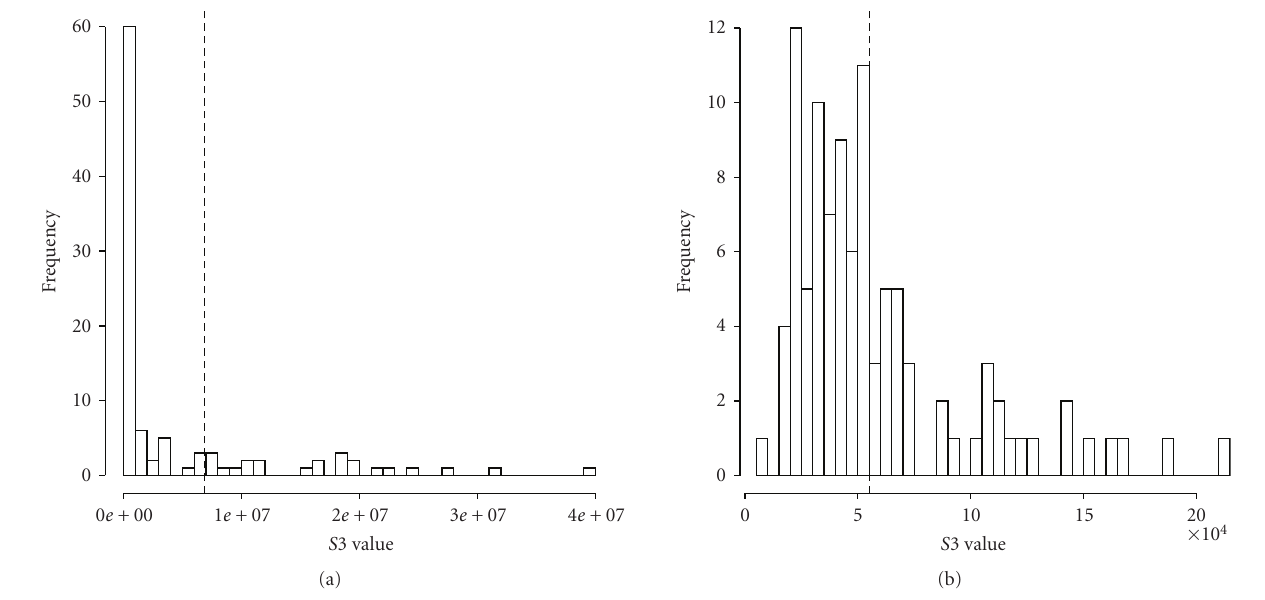
Figure 5: Histogram of 100 simulated values of S 3 for testing the separability of (a) mean temperature and mean sea level pressure and (b) mean humidity and precipitation. The dashed vertical line represents the value of S 3 calculated from the observed data.